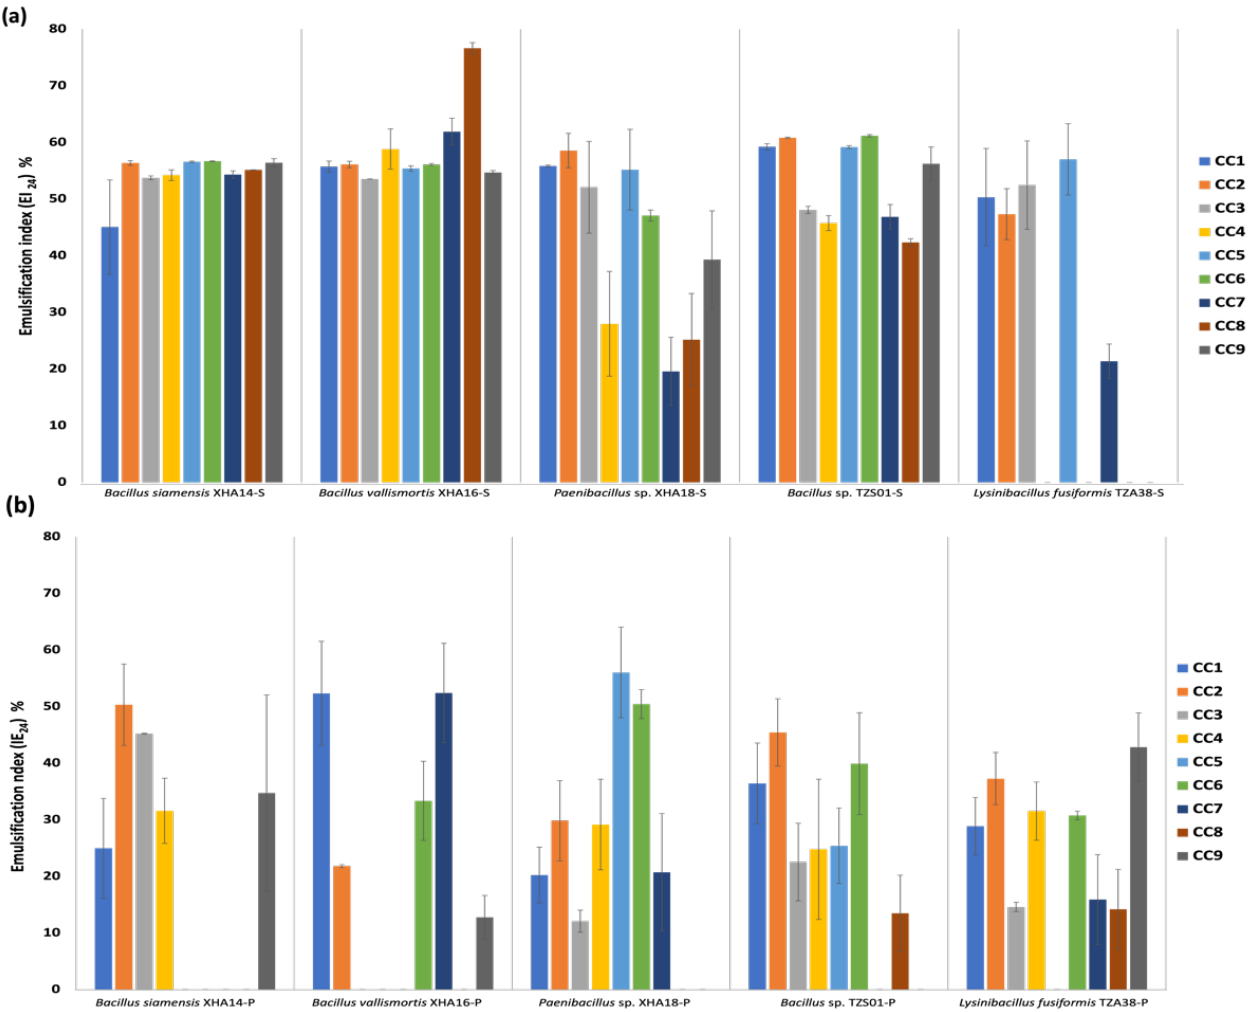
Figure 4. Optimization of culture conditions for bioemulsifier activity in sessile ( a ) and planktonic ( b ) systems of halotolerant bacteria.